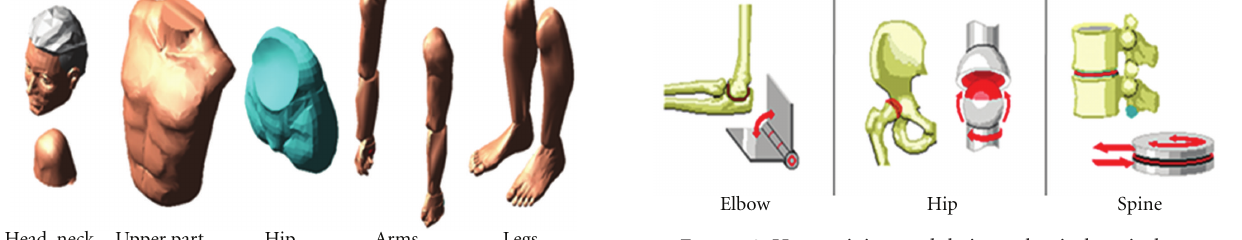
Figure 2: Human joints and their mechanical equivalent.